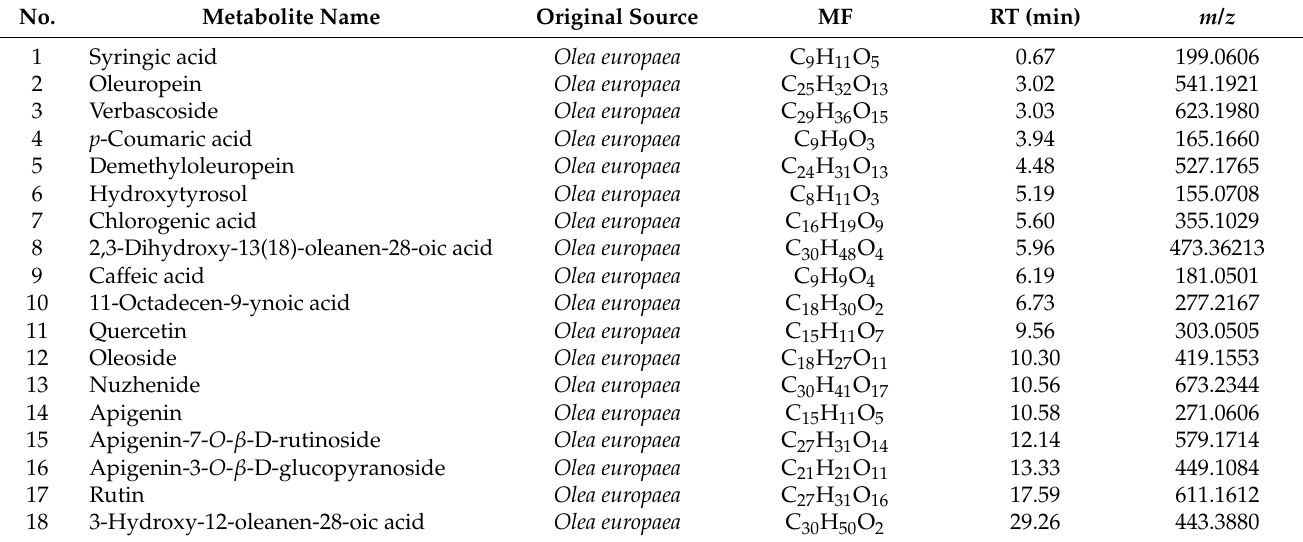
Figure 2. Dereplicated metabolites from LC-HRESIMS analysis of Olea europaea L. cv. Picual.